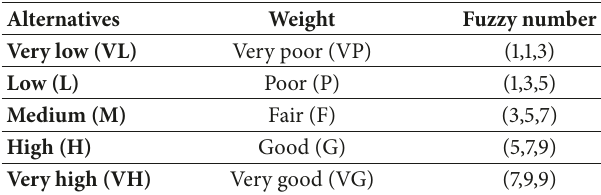
Table 3: Weights and alternatives with fuzzy numbers.